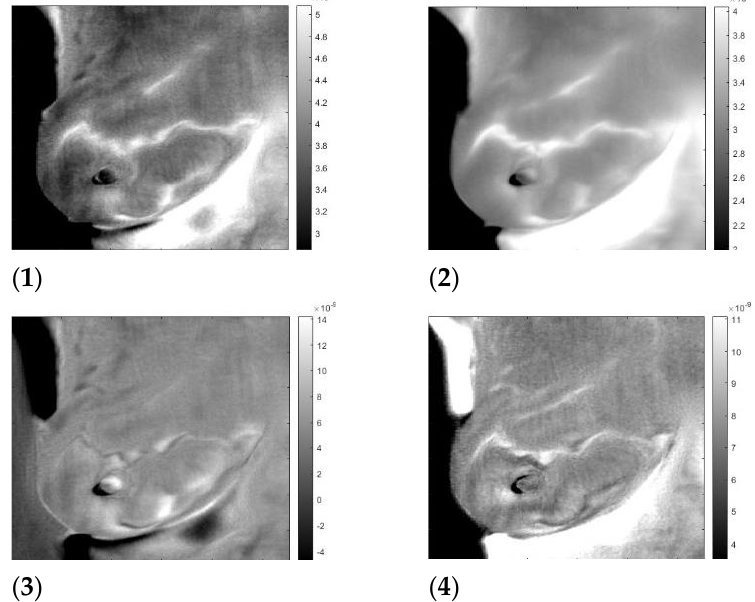
Figure 9. “Sick” left breast of patient #T285. Images 1 to 4 after application of the inverse ICA transform. ( 1 ) and ( 2 ) are images of thermal reflection, while ( 3 ) and ( 4 ) are images of vasoconstriction.